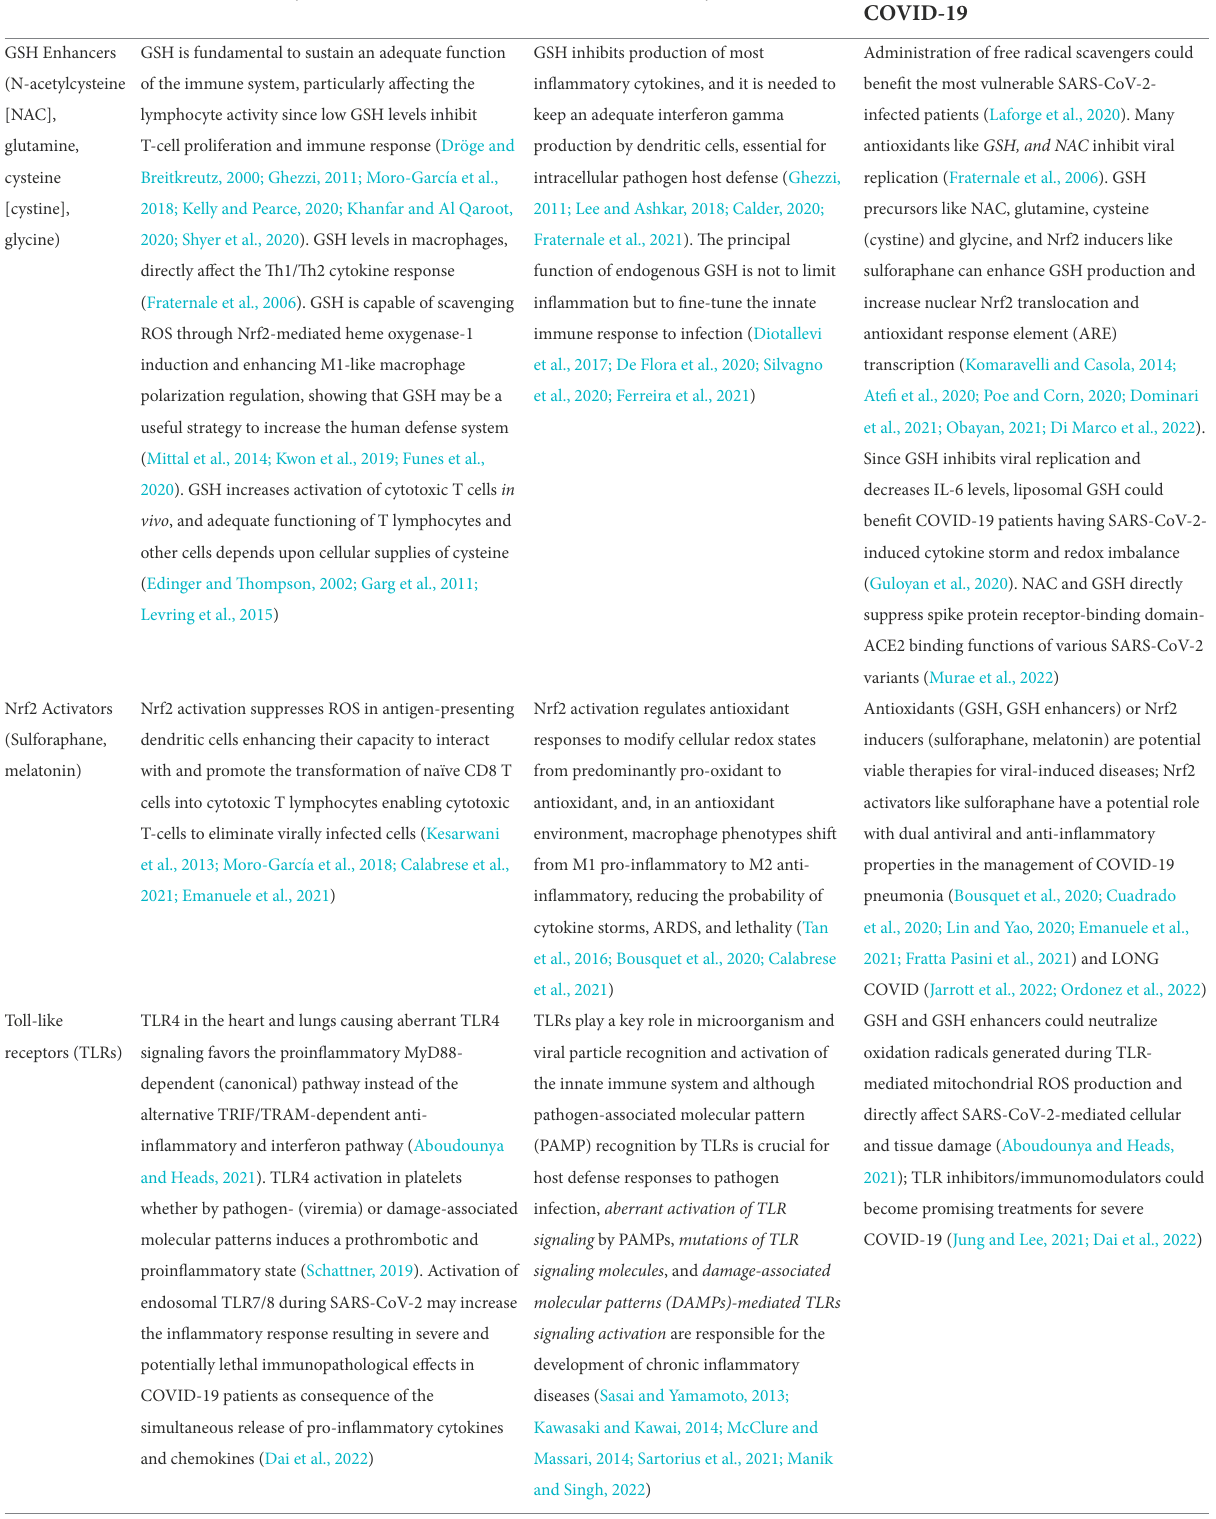
TABLE 1 Multi-weaponry approach involving glutathione (GSH) enhancers, nuclear factor erythroid 2 p45–related factor 2 (Nrf2) activators, toll- like receptor (TLR) inhibitors/immunomodulators, C-reactive protein (CRP) level reduction, natural and immune immunoglobulin M (IgM) enhancement and immune cell function recovery against SARS-CoV-2 infection and COVID-19